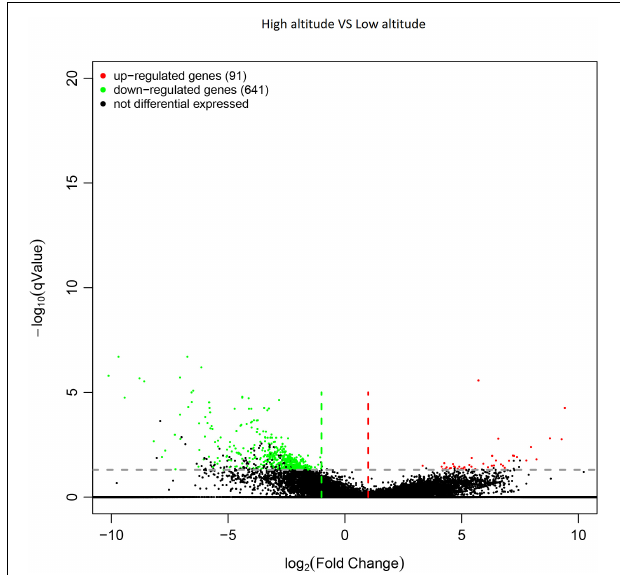
FIGURE 4 | Volcano plot of differentially expressed genes (DEGs) in the leaves of Cyclocarya paliurus between low and high altitudes.